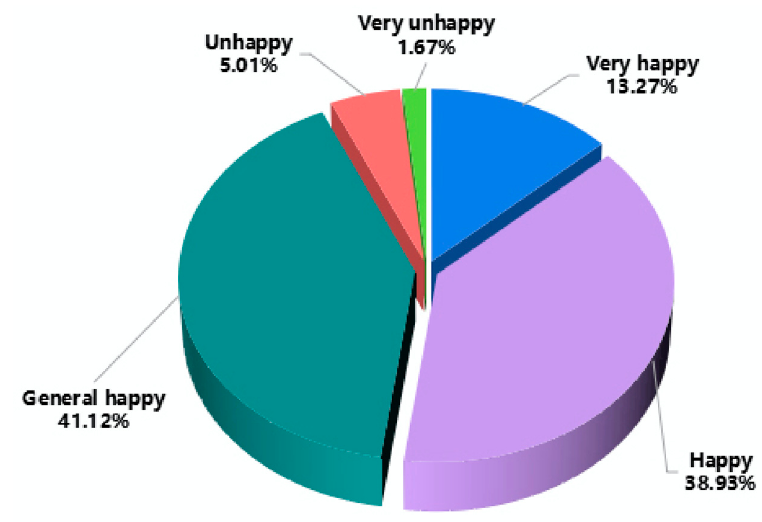
Figure 3. Distribution of farmers’ happiness.